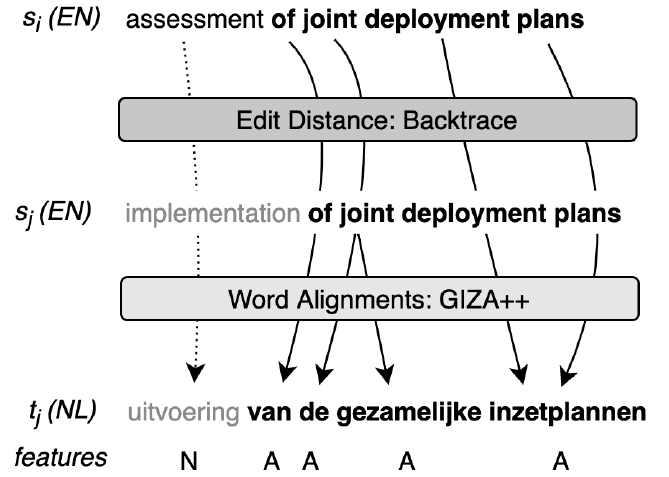
Figure 2. Aligning tokens of a source sentence ( s i ) with tokens of source and target sentences for a fuzzy match ( s j , t j ). The features “ A ” and “ N ” stand for “ aligned ” (i.e., relevant) and “ non-aligned ” (i.e., irrelevant),